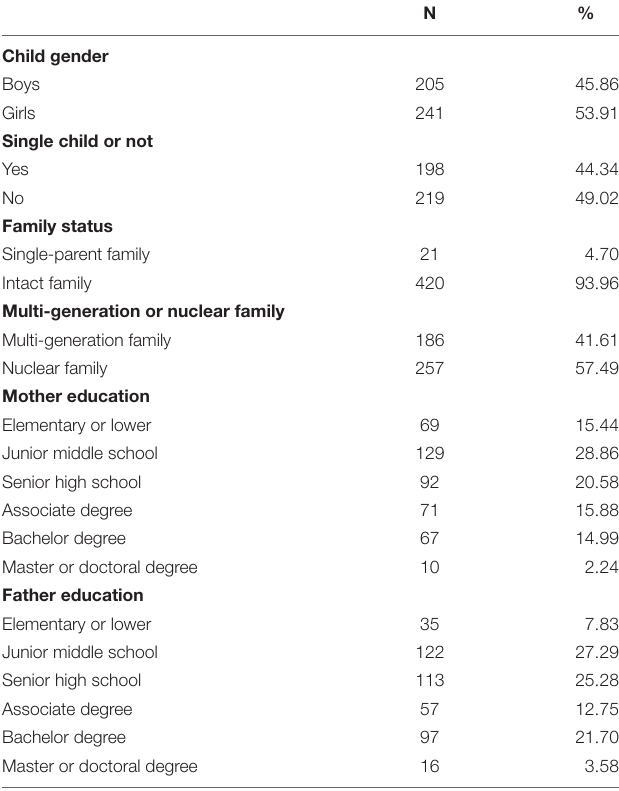
TABLE 1 | Demographic characteristics of the